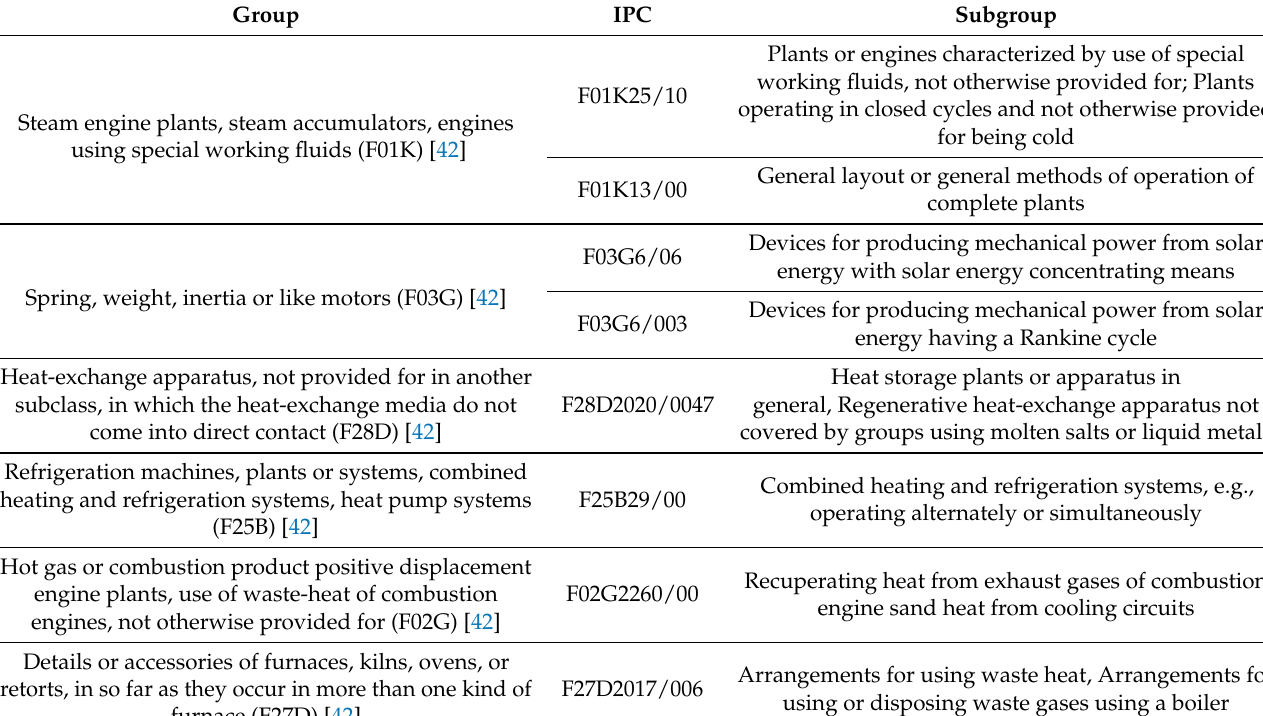
Table 2. IPC classification of selected